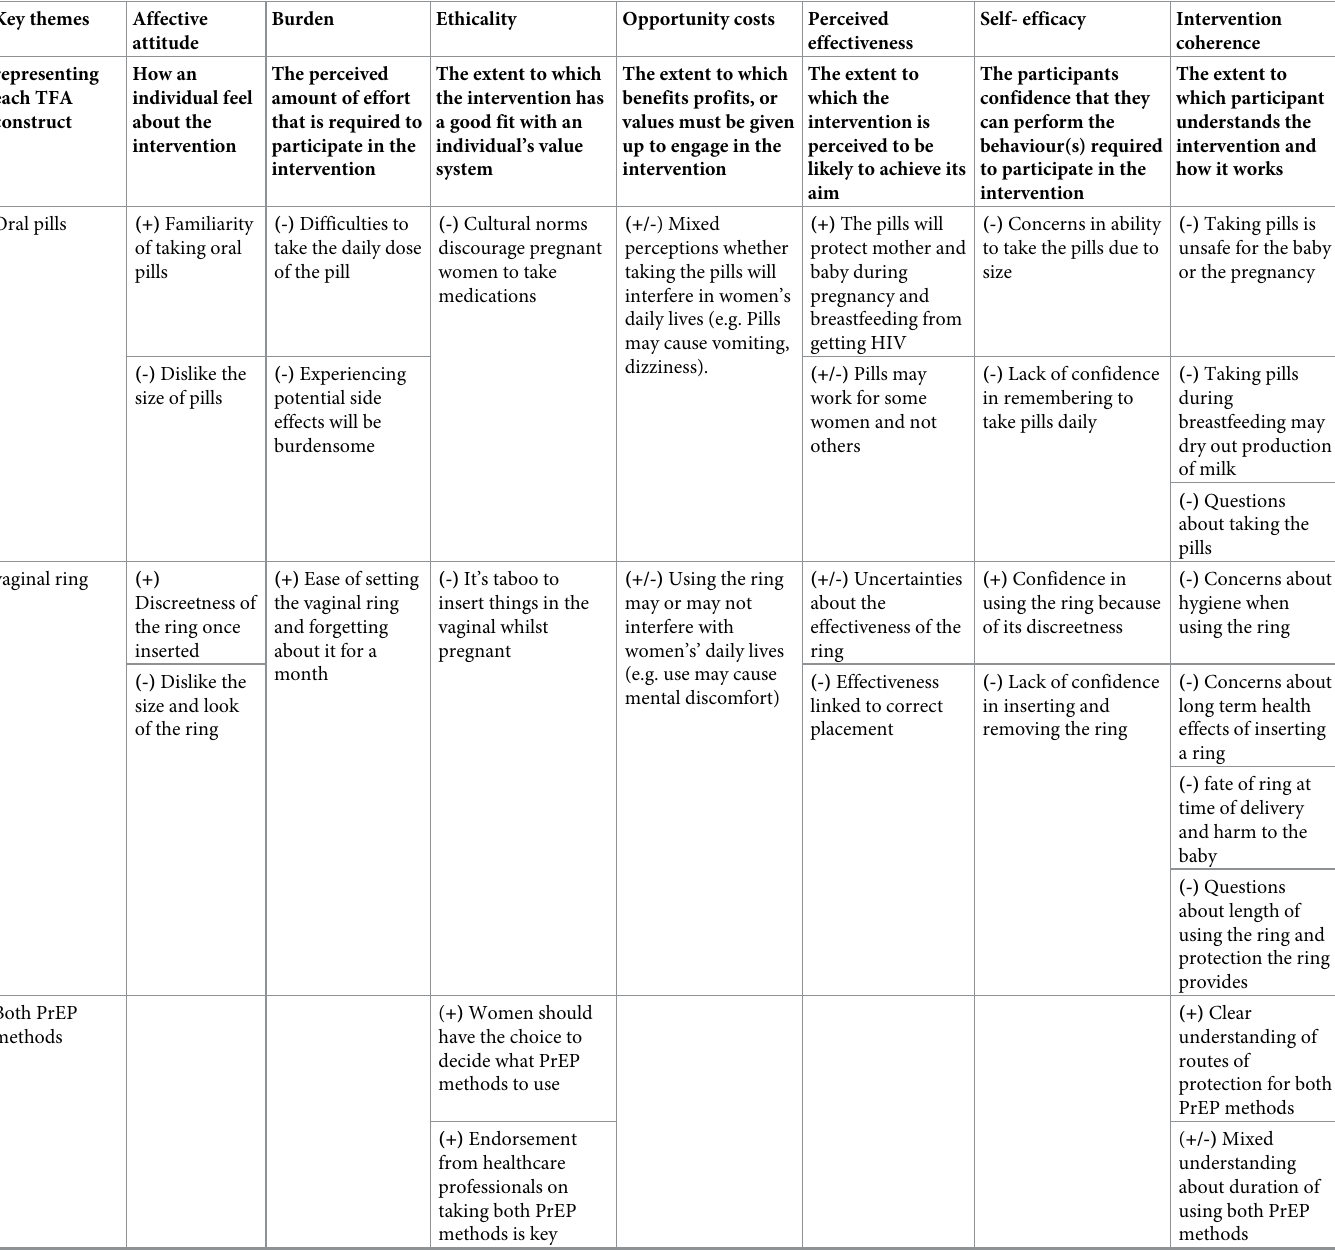
Table 3. Themes within the TFA construct representing prospective acceptability of oral PrEP and vaginal ring during pregnancy and